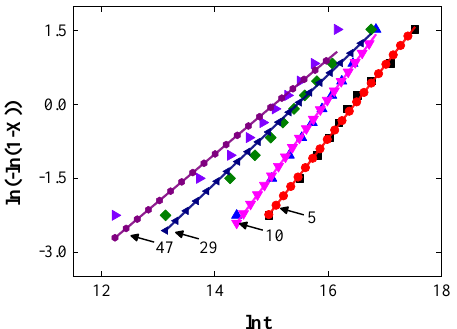
( ) 1 ln ln X − − vs. lnt .